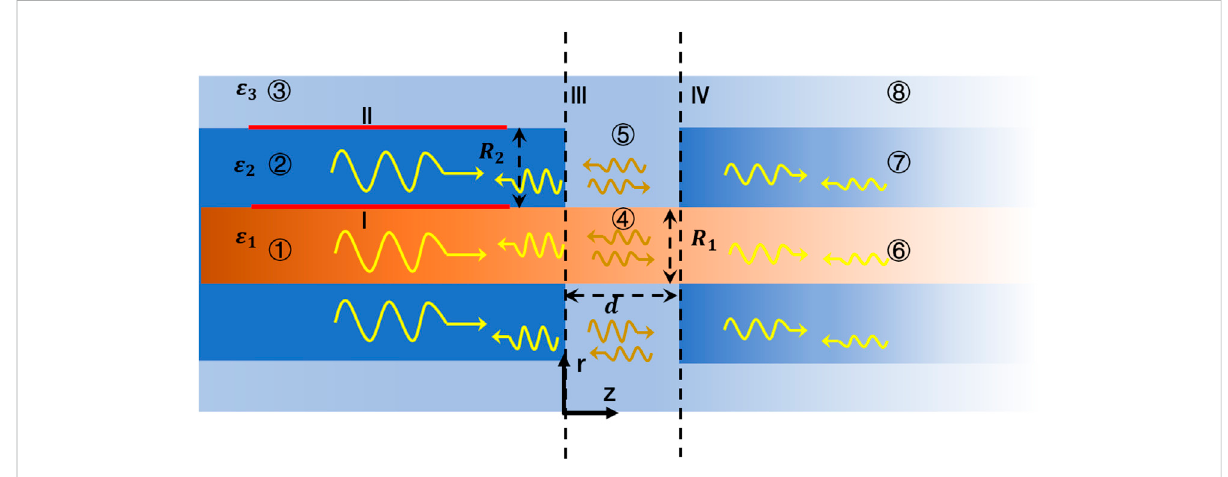
FIGURE 2 Schematic diagram of one node of Ranvier structure, and electromagnetic wave transmissions and re fl